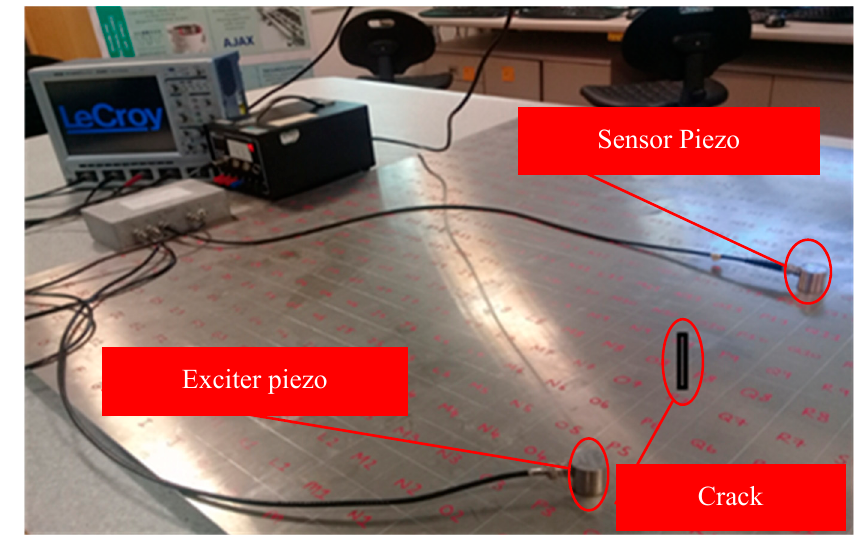
Figure 6. Pitch-catch method. Figure 6 . Pitch-catch method. Figure 6 . Pitch-catch method.